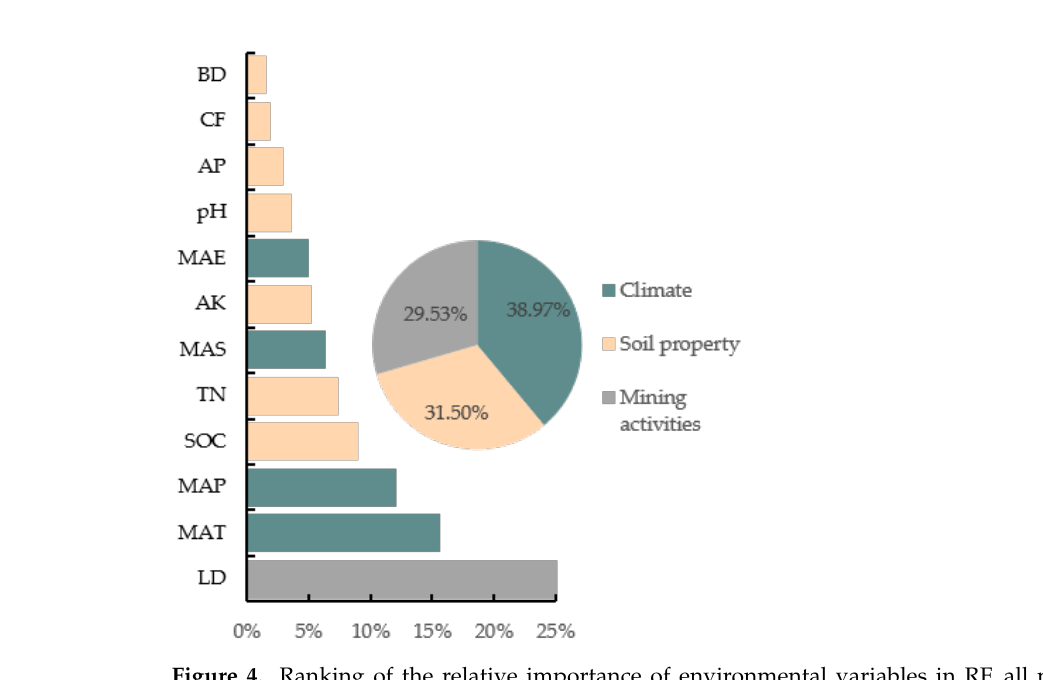
Figure 4. Ranking of the relative importance of environmental variables in RF_all model. All abbreviations (BD, CF, MAT, SOC, etc.) can be found in Table 1.